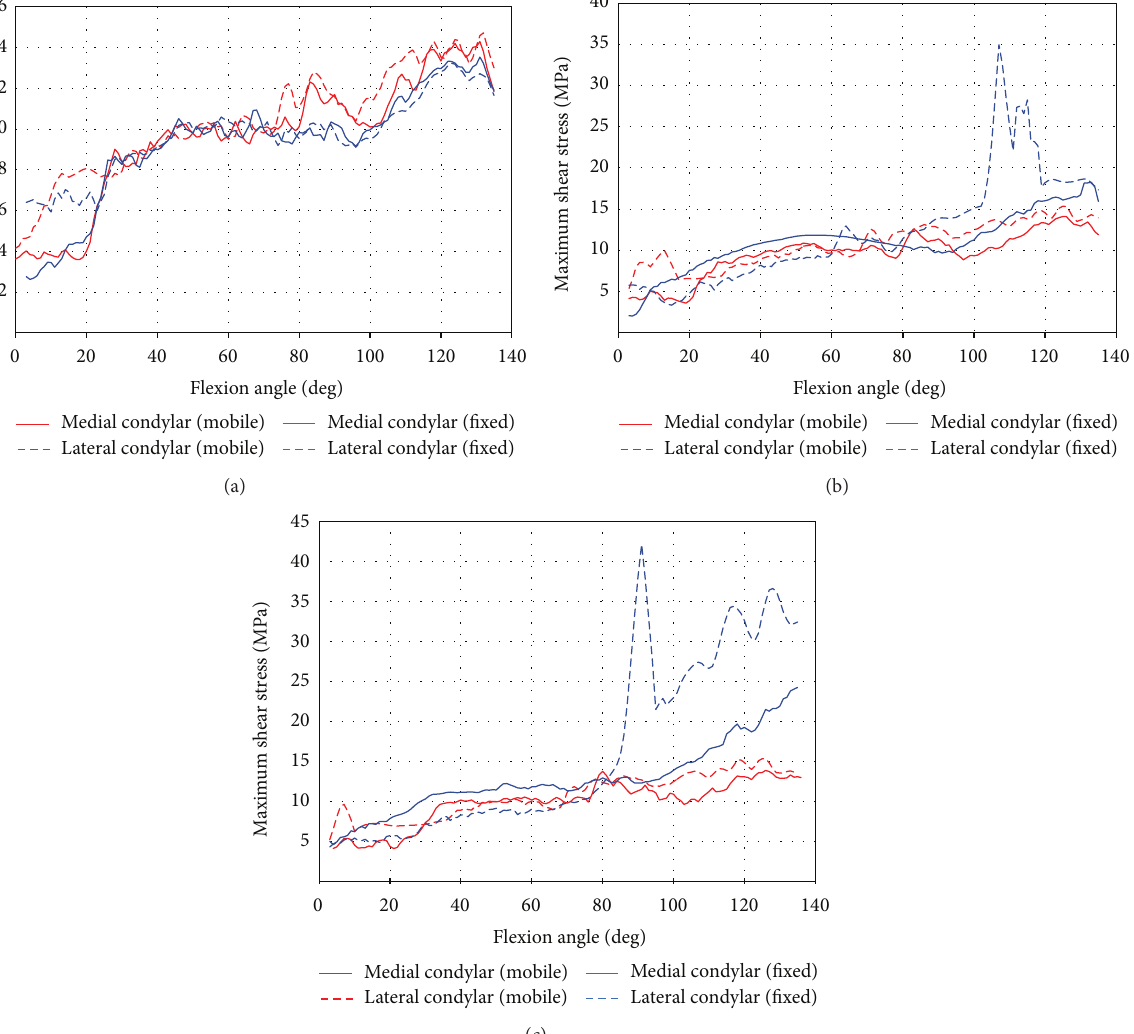
Figure 2: Maximum shear stress history from 0 ∘ to 135 ∘ of flexion angle. (a) Neutral position. (b) 10 ∘ tibial rotation. (c) 20 ∘ tibial